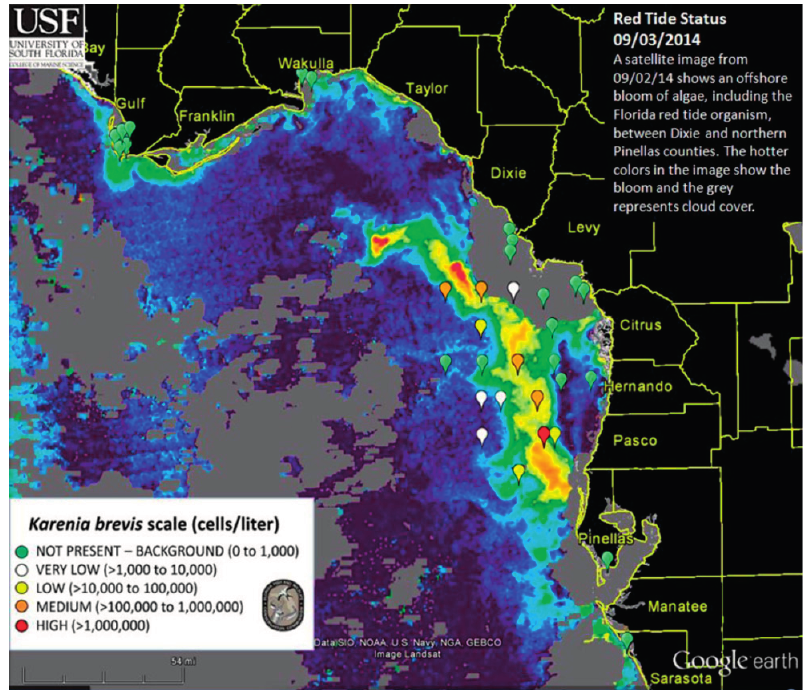
Figure 1. A sample HAB bulletin created and distributed weekly or twice weekly (MyFWC.com/RedTideStatus) by the Florida Fish and Wildlife Conservation Commission (FWC), the official agency of the state of Florida responsible for red tide